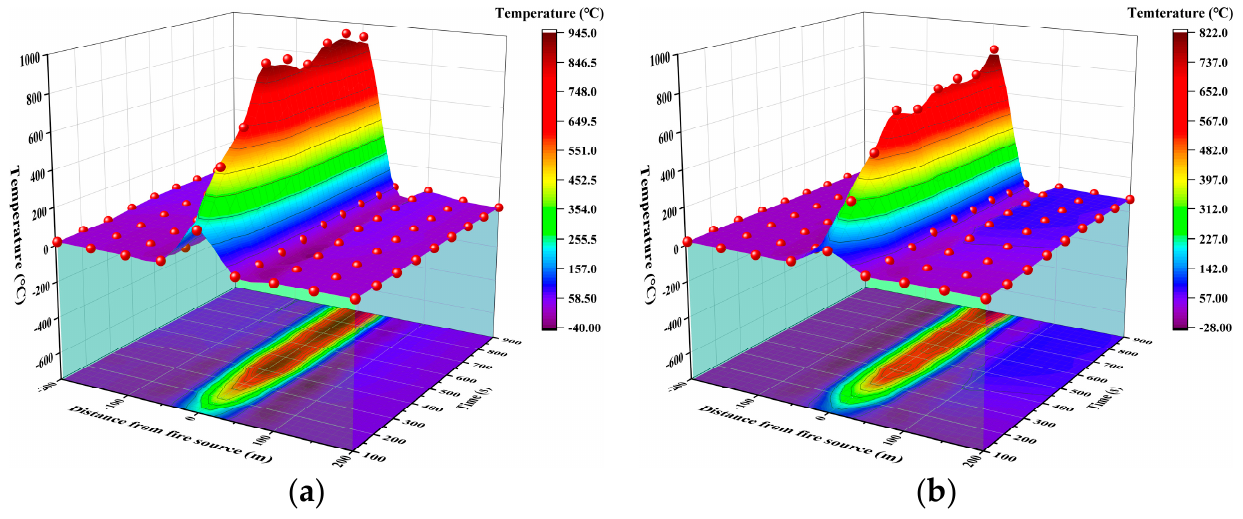
Figure 13. Three-dimensional curves of temperature with time and distances: ( a ) 0.5 m/s; ( b ) 3.6 m/s.